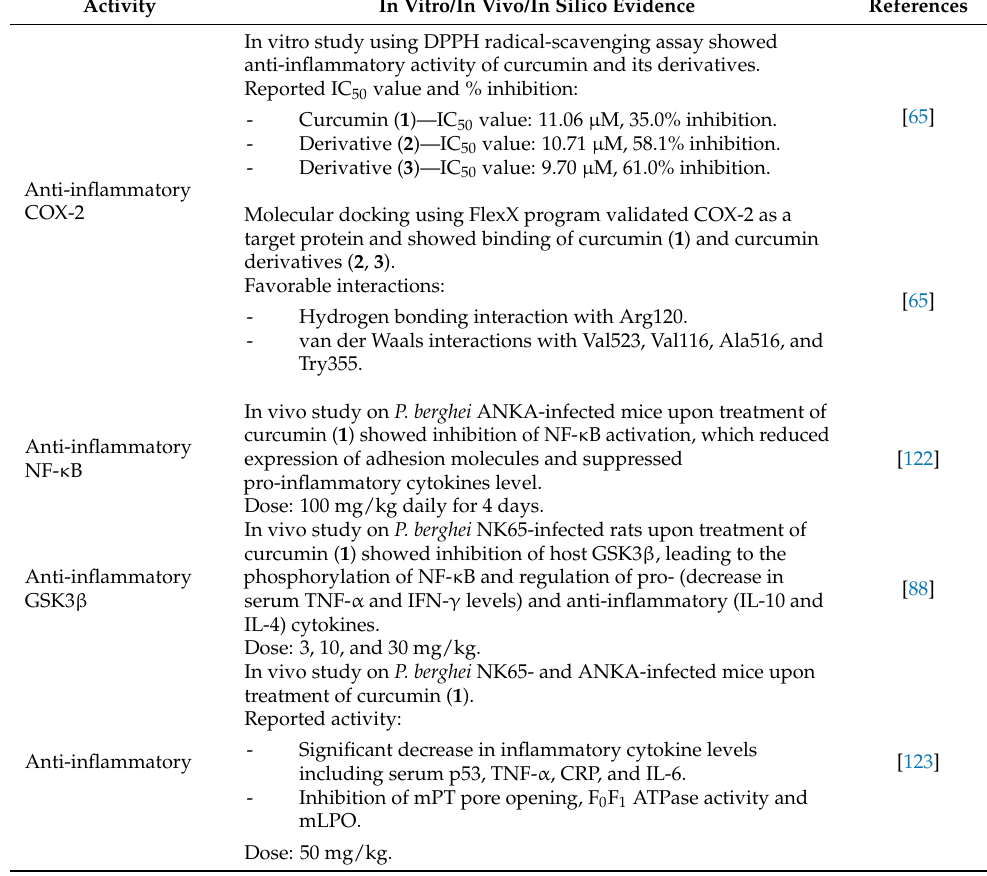
Table 4. Cont. Activity In Vitro/In Vivo / In Silico Evidence